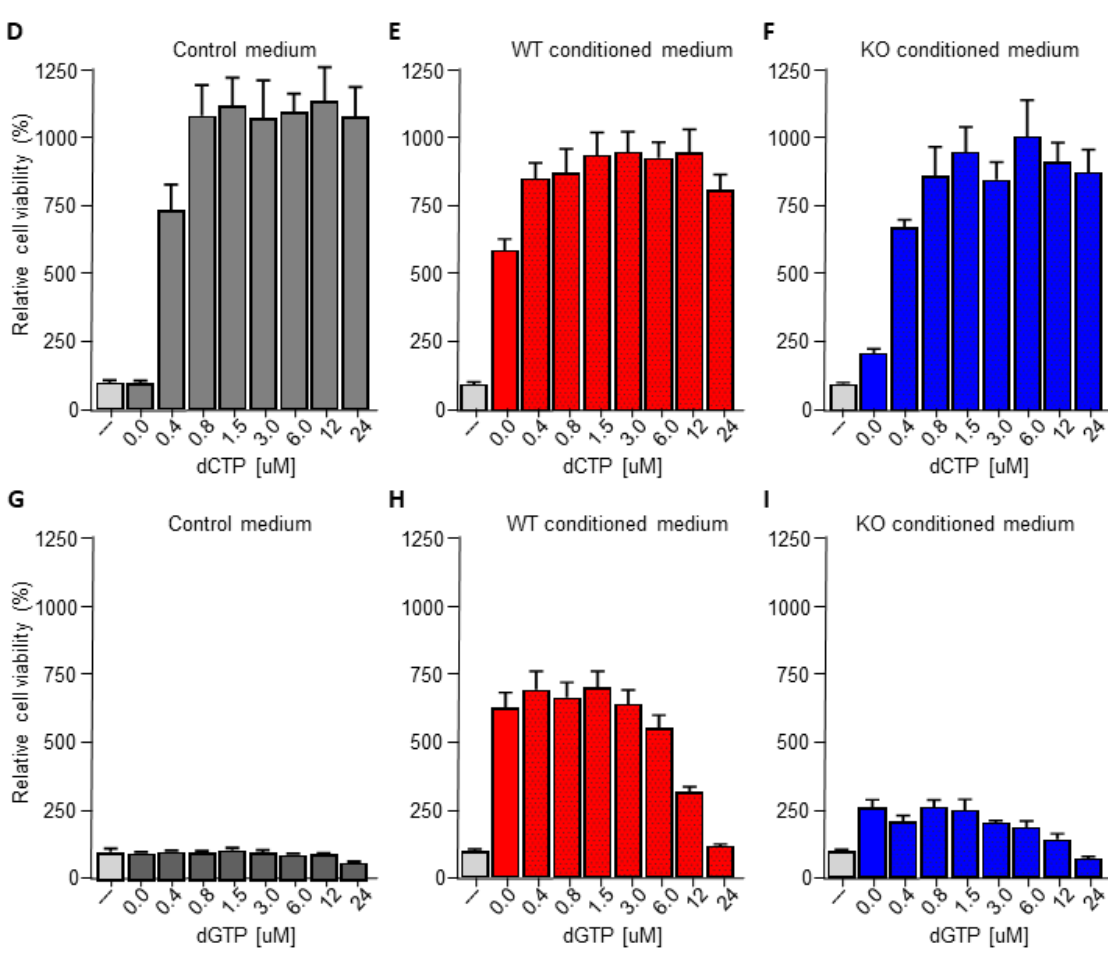
Figure 3. Macrophage C/EBP δ drives gemcitabine resistance in a deoxycytidine-dependent manner. ( A ) Schematic overview of the experimental set up. ( B ) Viability of Mia PaCa-2 pancreatic cancer cells in control medium (—), unfractionated conditioned medium obtained from wild type macrophages (Ctrl-CM), in the flow through fraction containing free metabolites (<10 kD) and in the fraction that retained on the filter (remains) in the presence of gemcitabine. **** p < 0.0001; ns: not significant. ( C ) Viability of Mia PaCa-2 pancreatic cancer cells in control medium (—), boiled DMEM (DMEM 100 ◦ C) or boiled conditioned medium obtained from wild type macrophages (CM 100 ◦ C) in the presence of gemcitabine. **** p < 0.0001. ( D – F ) Viability of Mia PaCa-2 pancreatic cancer (dCTP). ( G – I ) Viability of Mia PaCa-2 pancreatic cancer cells in control medium ( G ) or conditioned